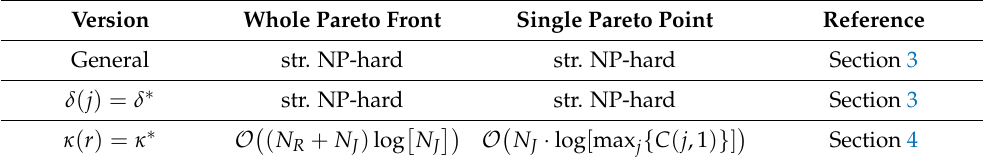
Table 1. Overview of complexity results for problem ( TAP ) . Note that δ ( j ) = δ ∗ denotes the case where all return times are identical and κ ( r ) = κ ∗ denotes the case where all transporter capacities are identical. Finally, C ( j ,1 ) denotes the completion time of job j when exactly one transporter is assigned to it, in the case where all transporters have identical